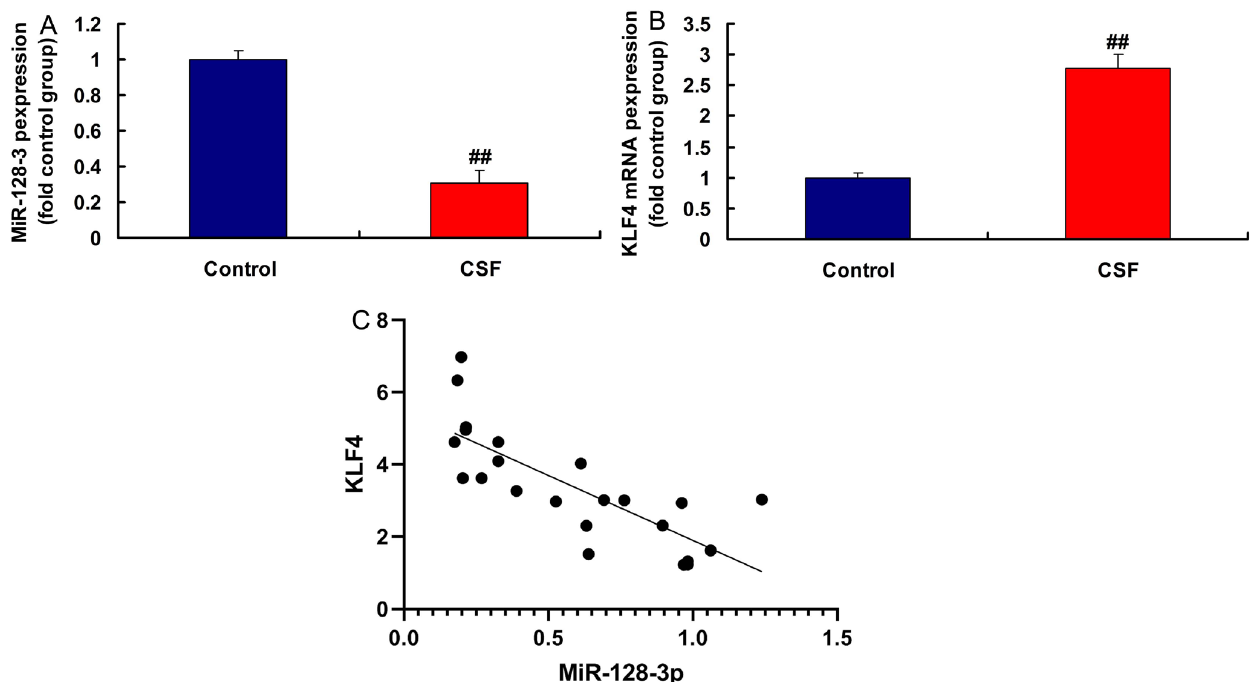
Fig. 4 - Micro ribonucleic acid (MiR)-128-3p and Kruppel-like factor (KLF) 4 expressions in the coronary slow flow (CSF) model (A and B), miR- 128-3p expression had a negative correlation with KLF4 levels in the rat model (C). Control, normal volunteer group; CSF, CSF patients group. ## P<0.01 compared with normal volunteer group. mRNA=messenger ribonucleic